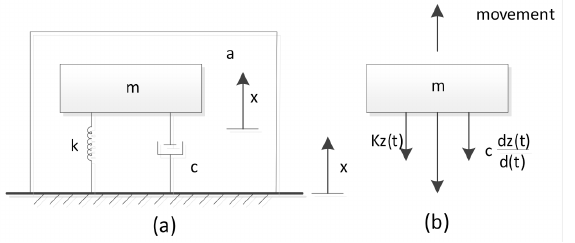
Figure 1. Schematic of the accelerometer. ( a ) Lumped model of the accelerometer. ( b ) The force on the sensitive mass. k is the elastic coefficient of the spring, c is the damping coefficient, x is the relative displacement between the mass and the base, a is the acceleration acting on the